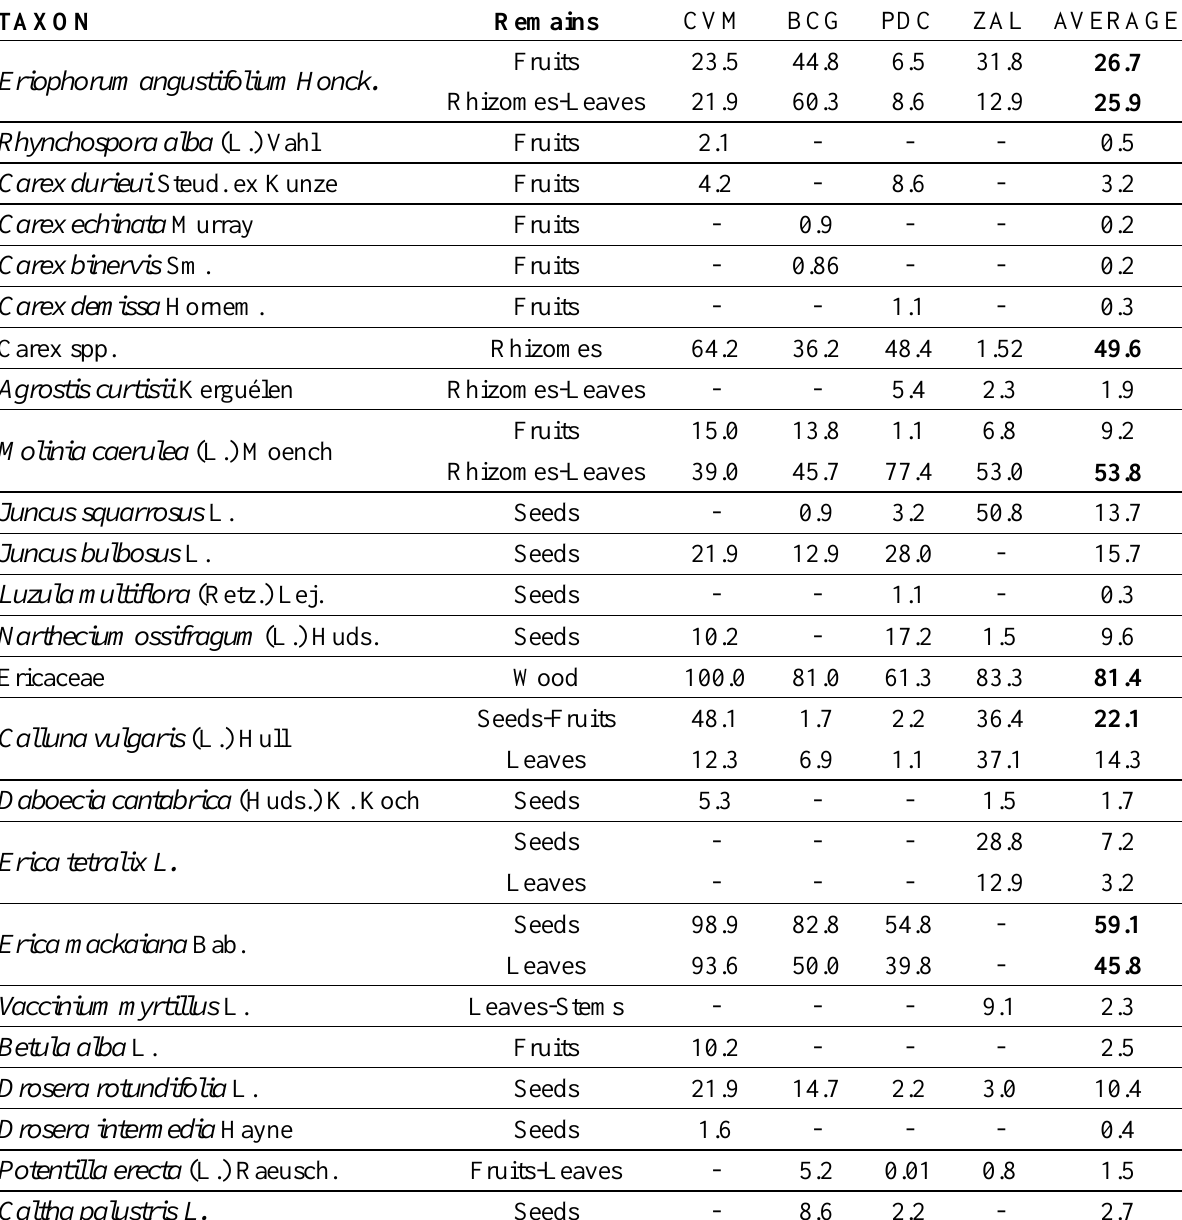
Table 3. Relative frequencies (%) of the plant macrofossils identified for each sampled bog (CVM: Chao de Veiga Mol; BCG: Borralleiras de Cal Grande; PDC: Pena da Cadela; ZAL: Zalama) and for all sampled bogs (AVERAGE). In the last column, values for the most frequent species are shown in bold